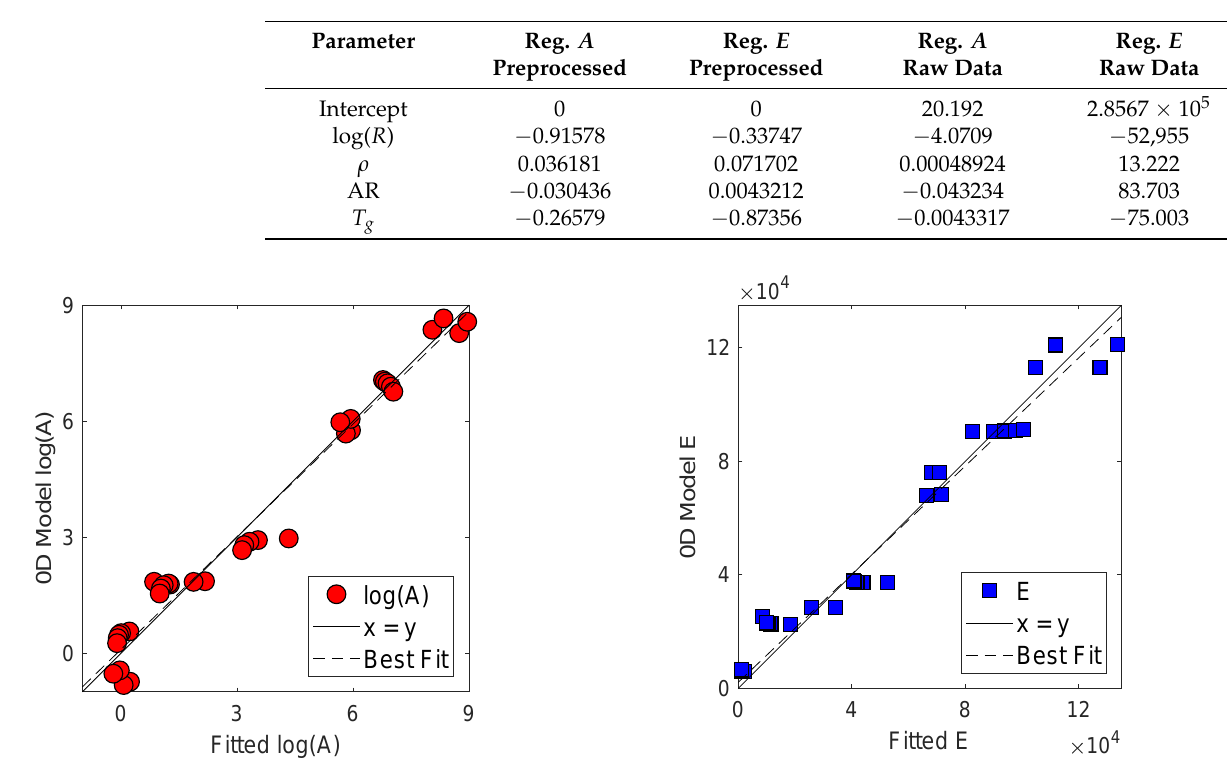
Figure 6. Comparison of log ( A ) and E determined from a fit to the semi-2D model and as predicted by the 0D lumped kinetics from model 2 and 2, see Tables 3 and 4. Best fit linear regressions have r 2 = 0.97 and r 2 = 0.95 for the log ( A ) and E graphs,